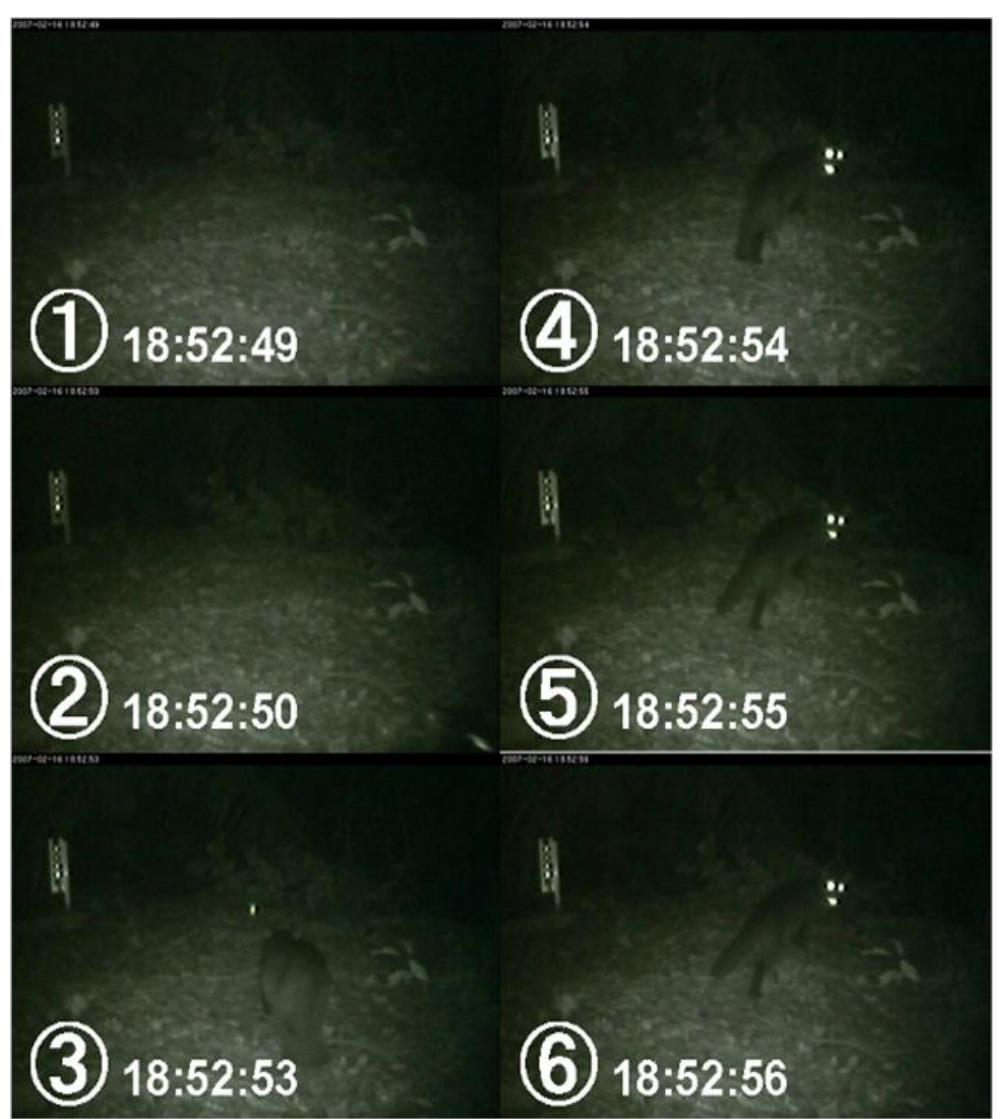
Figure 17. Infrared pictures taken by our